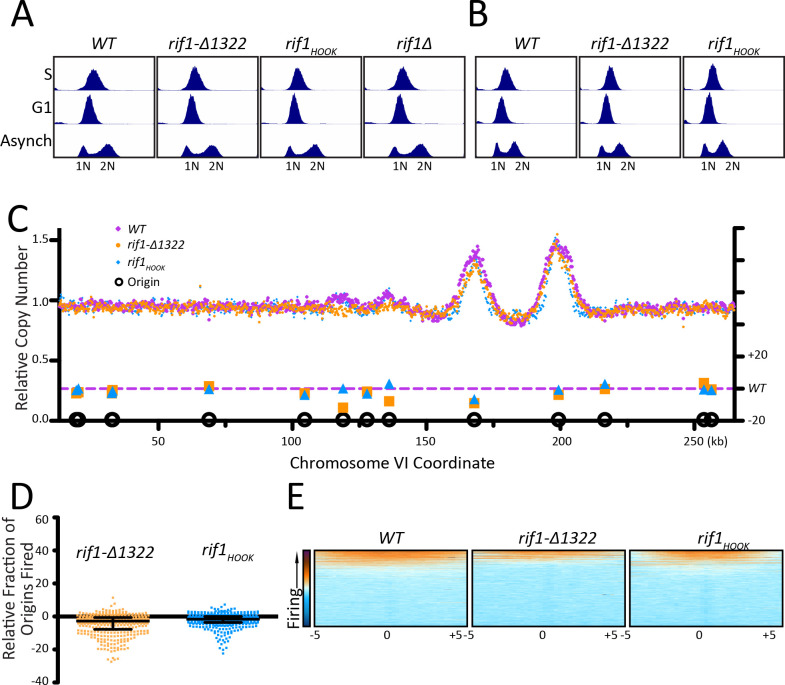
Mutations in Rif1 that increase telomere length do not affect origin firing across the genome.(A) The DNA content of the arrested cells in Figure 4C was measured using flow cytometry. (B) The DNA content of the arrested cells in Figure 4D was measured using flow cytometry. (C) Relative copy number for the entire Chromosome VI is shown. WT is in purple, rif1-∆1322 is in orange, and rif1HOOK is in blue, relating to Figure 4D. (D) The relative copy number for 1 kb around the midpoint of each origin was calculated for each strain. For each peak, the WT value was subtracted from RIF1 mutant value and multiplied by 100. Median and interquartile range are plotted over the distribution, and one-sided Wilcoxon signed rank test used to test significance: rif1-∆1322 (p=1) and rif1HOOK (p=1). (E) Heatmap of relative copy number for 10 kb region centered at each OriDB origin. Orange indicates high copy number and blue indicates low copy number. Origins are sorted based on highest copy number to lowest copy number.